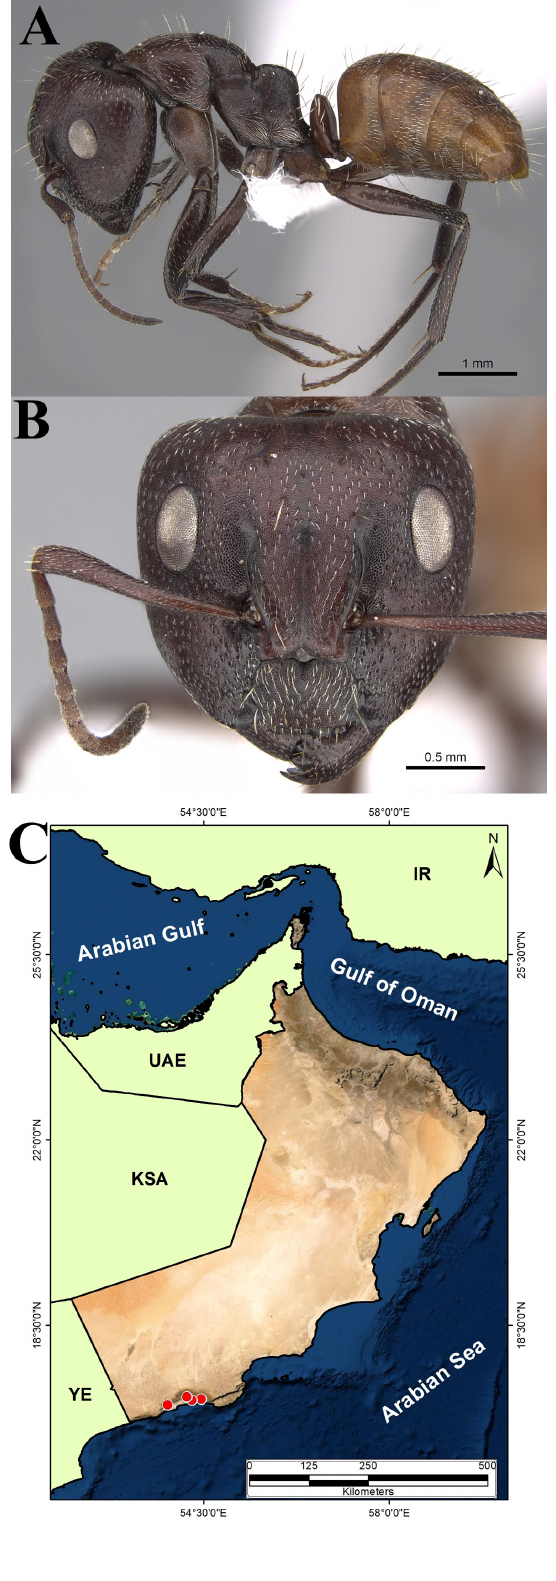
Fig. 6. Camponotus diplopunctatus Emery, 1915, major worker (CASENT0922847, AntWeb.org (Michele Esposito)). A . Body in profile. B . Head in full-face view. C . Distribution